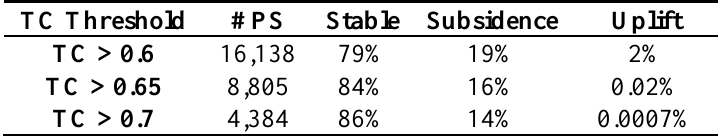
Table 4. A classification of the PSI observations using different Temporal Coherence (TC) thresholds.